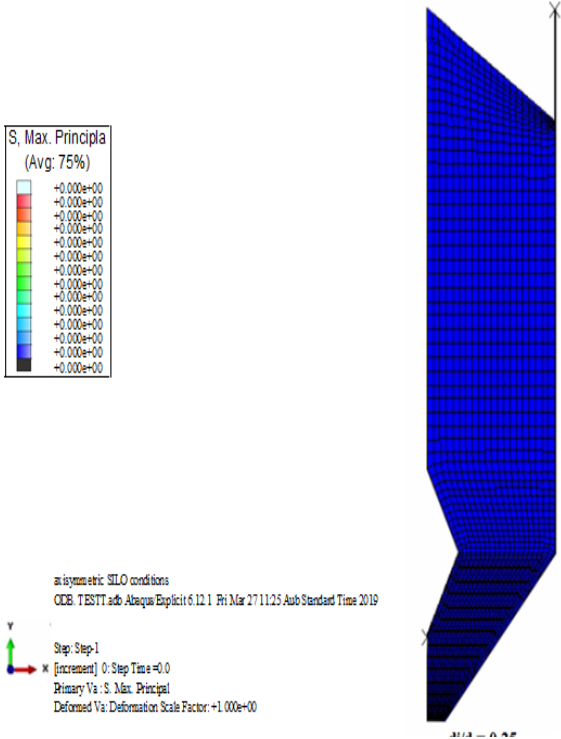
Figure 21: The comparison is between the pressure produced by the numerical study and the pressure registered by the experimental study with insert